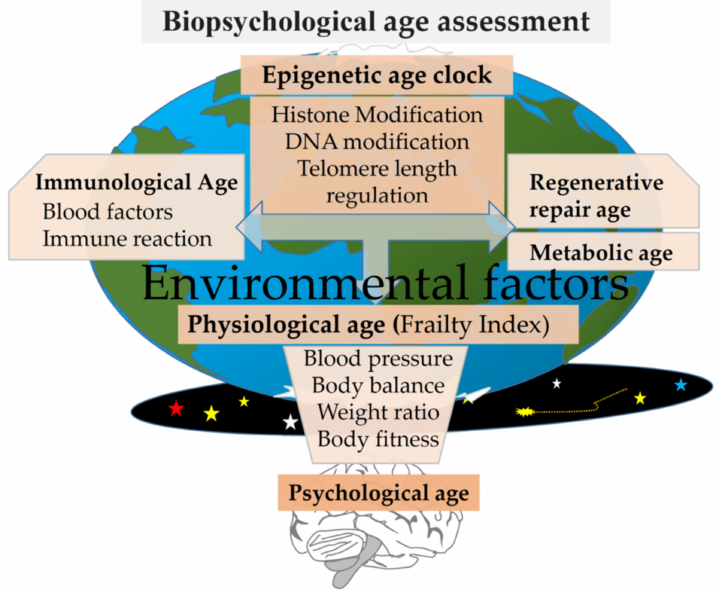
Figure 1. Psychological age and methods for assessing biological age showing the body system’s resistance to various environmental factors (arrows show the hierarchy and interactions of body systems involved/reflecting the aging